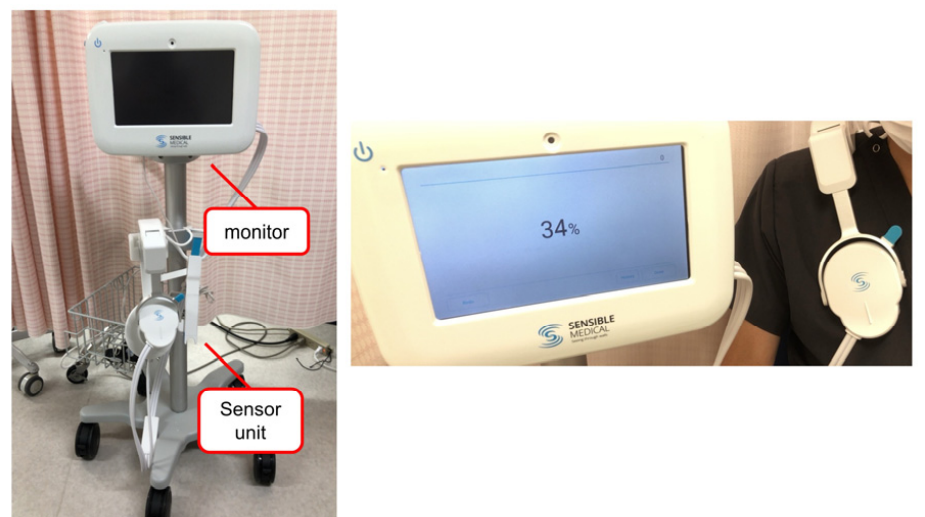
Figure 1. How to measure remoting dielectric sensing (ReDS) value. The device consists of a sensor unit and a monitor to display the results. Patients wear the sensor unit and wait for approximately one minute. ReDS value is displayed immediately after the measurement.